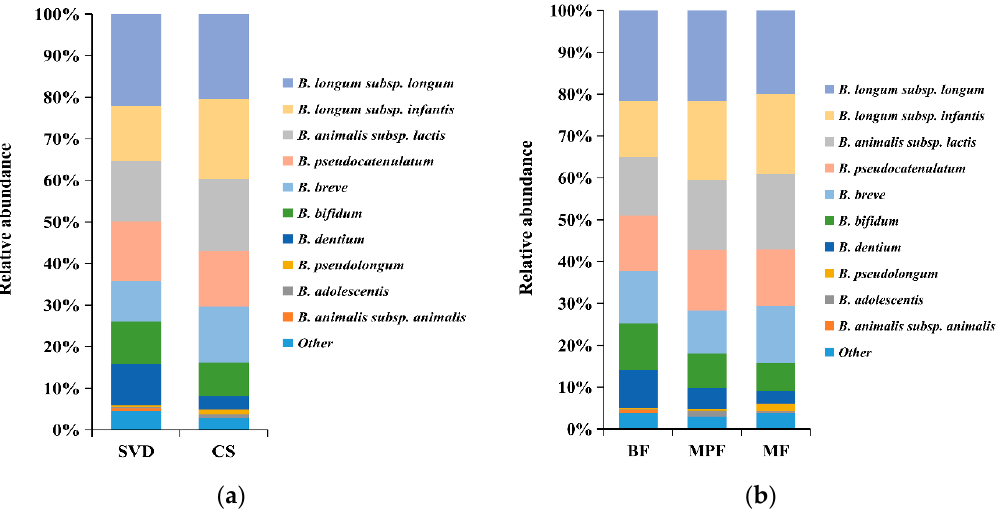
Figure 6. Bifidobacterial composition of infant guts in different delivery modes and feeding methods. ( a ) Delivery modes; ( b ) Feeding methods. Showing species found at >1% average in total population. Species found at <1% were grouped as “other”.